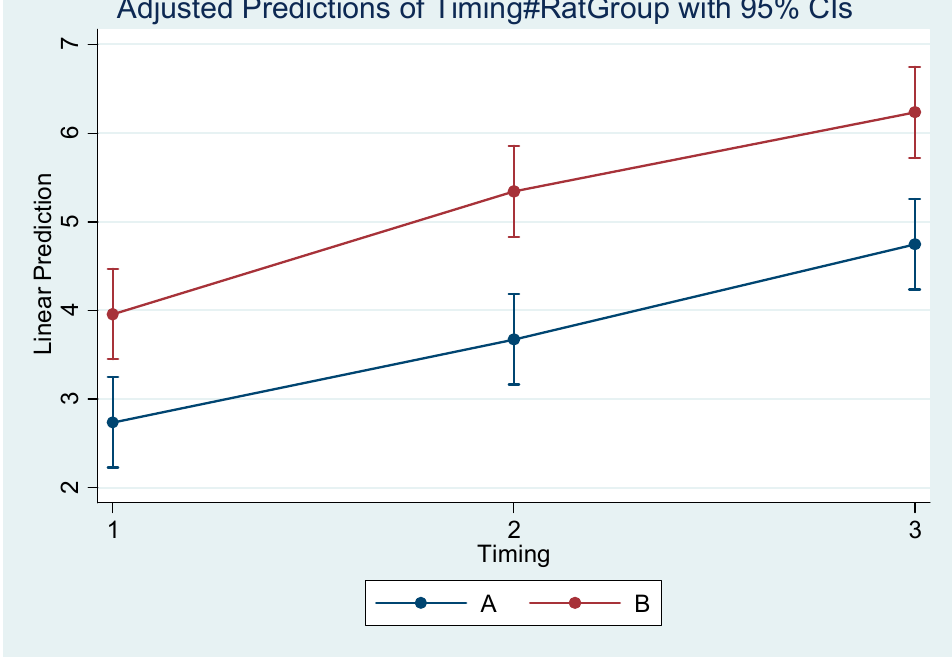
Figure 5. Estimated mean difference (Final–Initial) and 95% Confidence Interval per group and timing in Go–Menton (mandibular body length b).